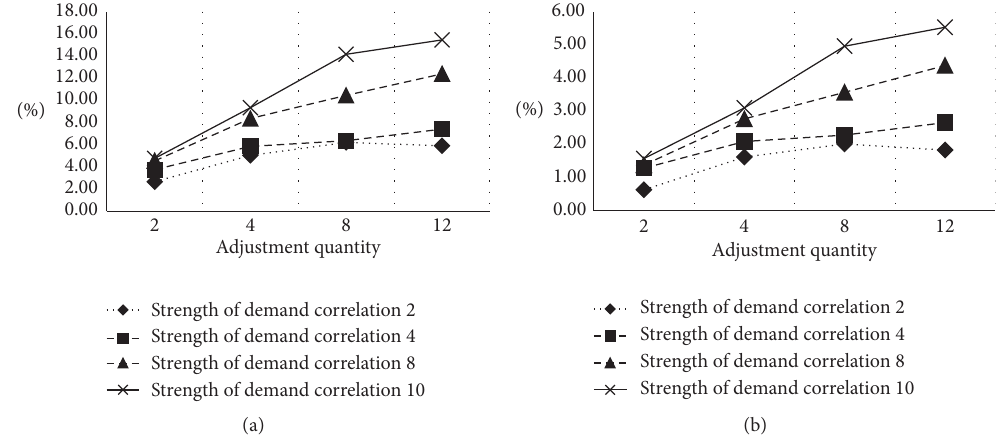
Figure 7: Co-optimization effect of adjustment quantity and strength of demand correlation: (a) saving distance and (b) saving time.